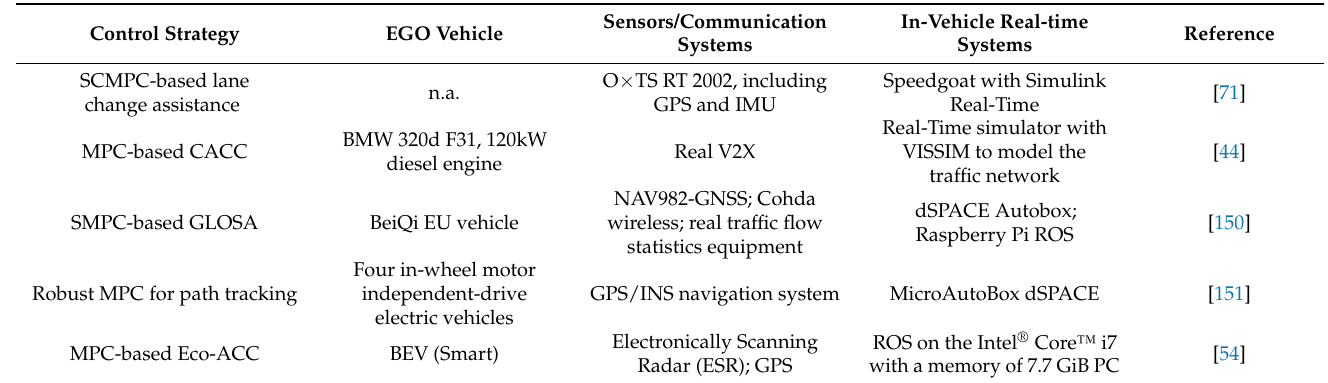
Table 3. Typical ViL/Driving Test